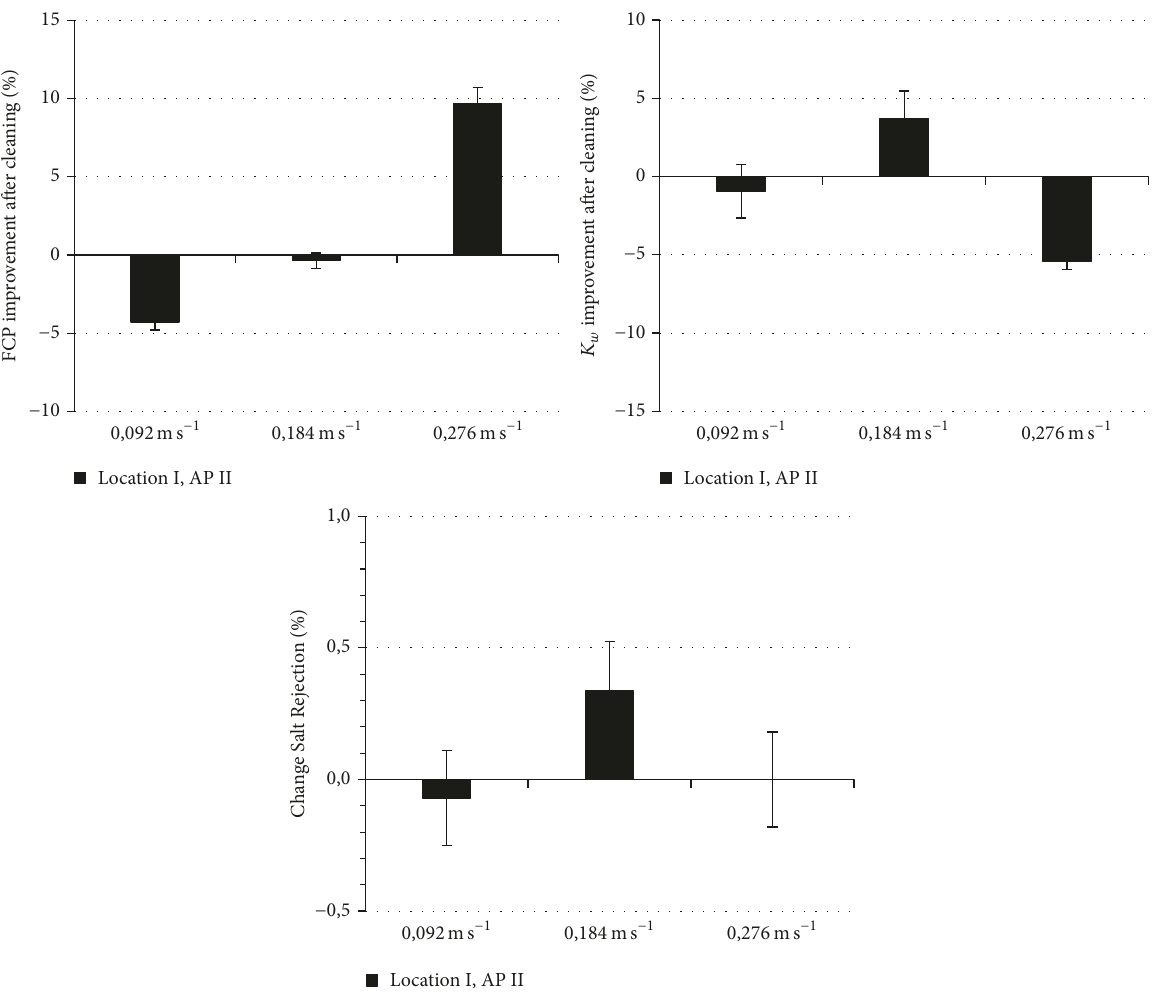
Figure 10: Normalized permeability, FCP, and salt rejection improvements after laboratory cleaning with AP II cleaning procedure for membrane and spacer samples from location I; error bars represent standard deviation (𝑛 = 2)